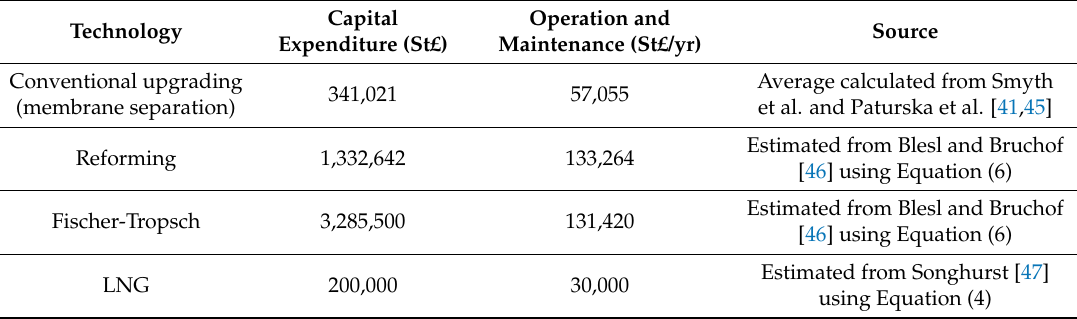
Table 5. Capital and operation and maintenance costs based on an AD plant producing ~860,000 m 3 /year of biogas.